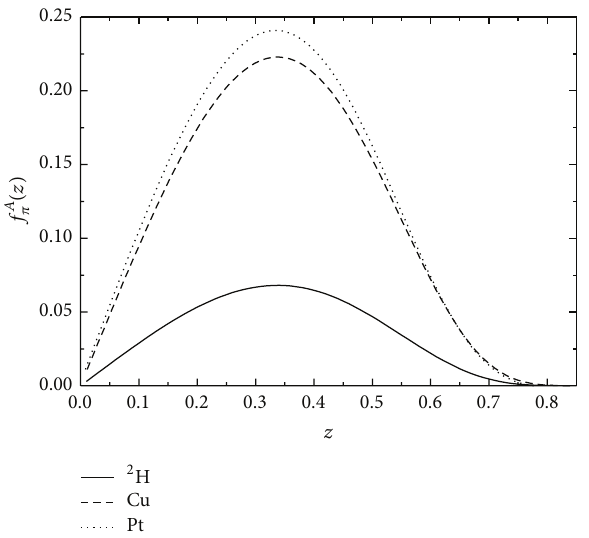
Figure 3: The distribution function of pion inside 2 H, 63 Cu, and 195 Pt nuclei.